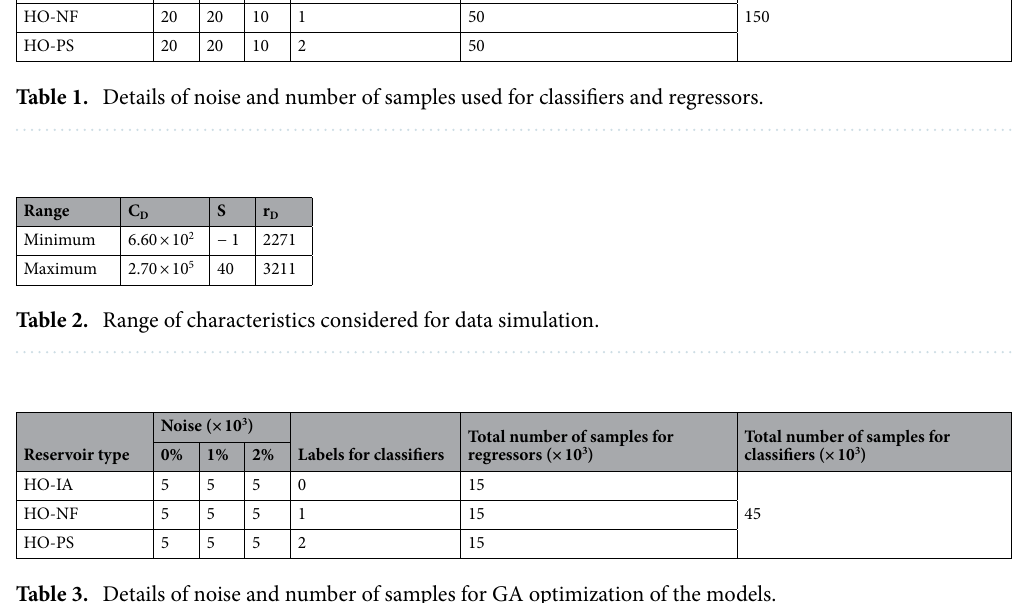
Table 3. Details of noise and number of samples for GA optimization of the models.